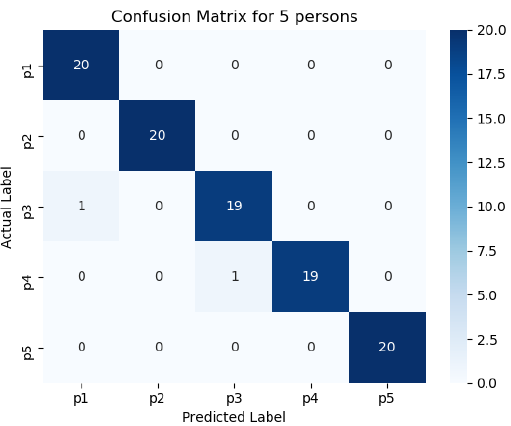
Figure 11. Confusion matrix of the proposed model for the five persons.